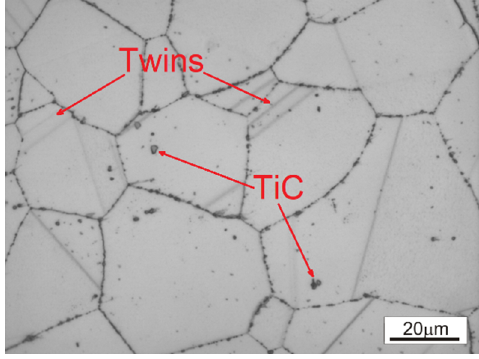
Figure 1. The initial microstructure of Waspaloy.